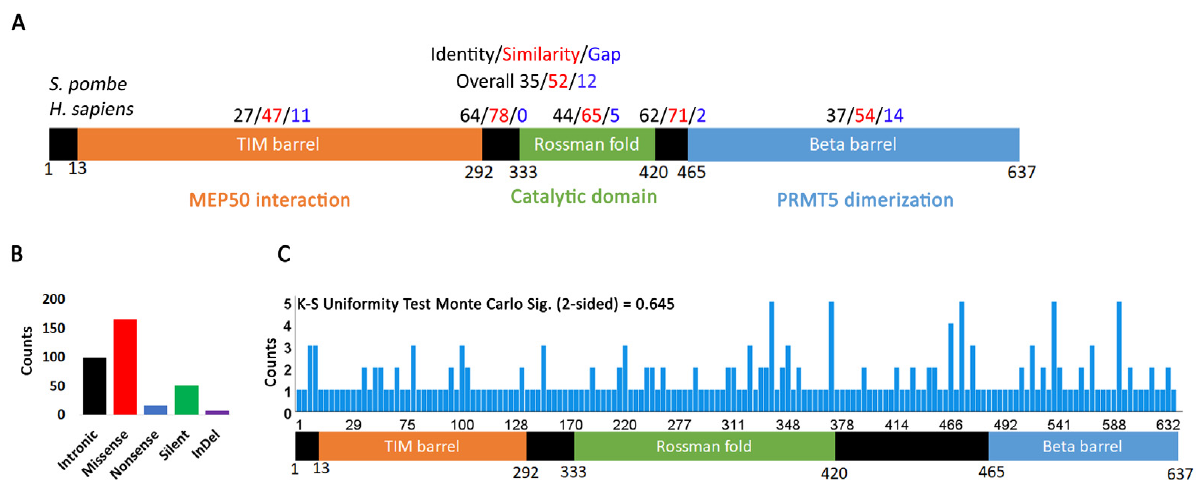
Figure 1. PRMT5 mutation distribution in human cancers. ( A ) Structure of PRMT5 protein showing conservation between S. pombe and H. sapiens . Residue conservation between the two species was determined using the NCBI Protein-BLAST tool. ( B ) Distribution of different types of PRMT5 mutations in human cancers. ( C ) Frequency of PRMT5 mutations occurring in the various protein regions. A one-sample Kolmogorov-Smirnov (K-S) test for uniformity was performed using SPSS. The Monte Carlo two-sided significance value is 0.645, indicating that mutations distribute uniformly over the PRMT5 region.